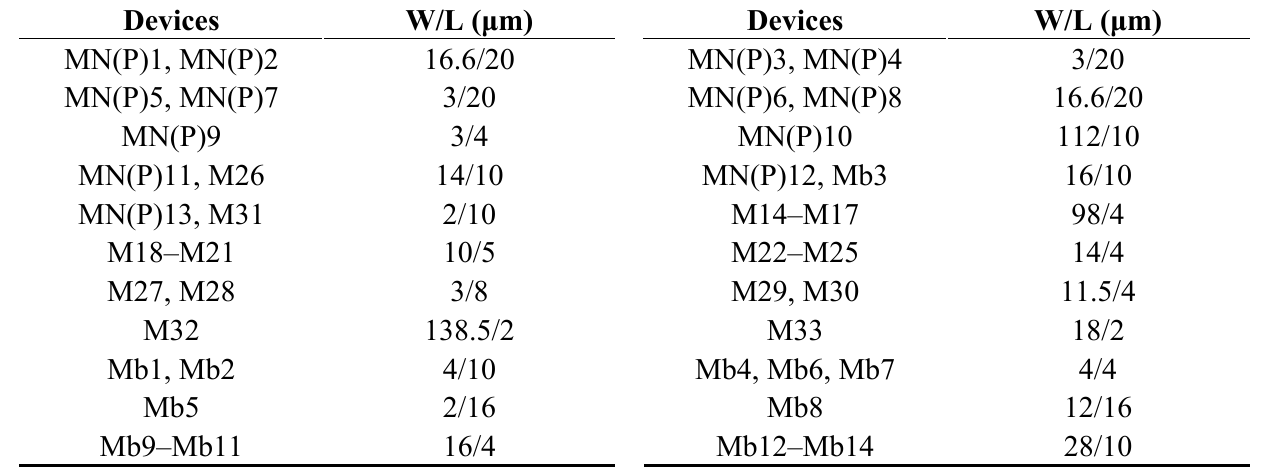
Table 1. Transistor dimensions of the